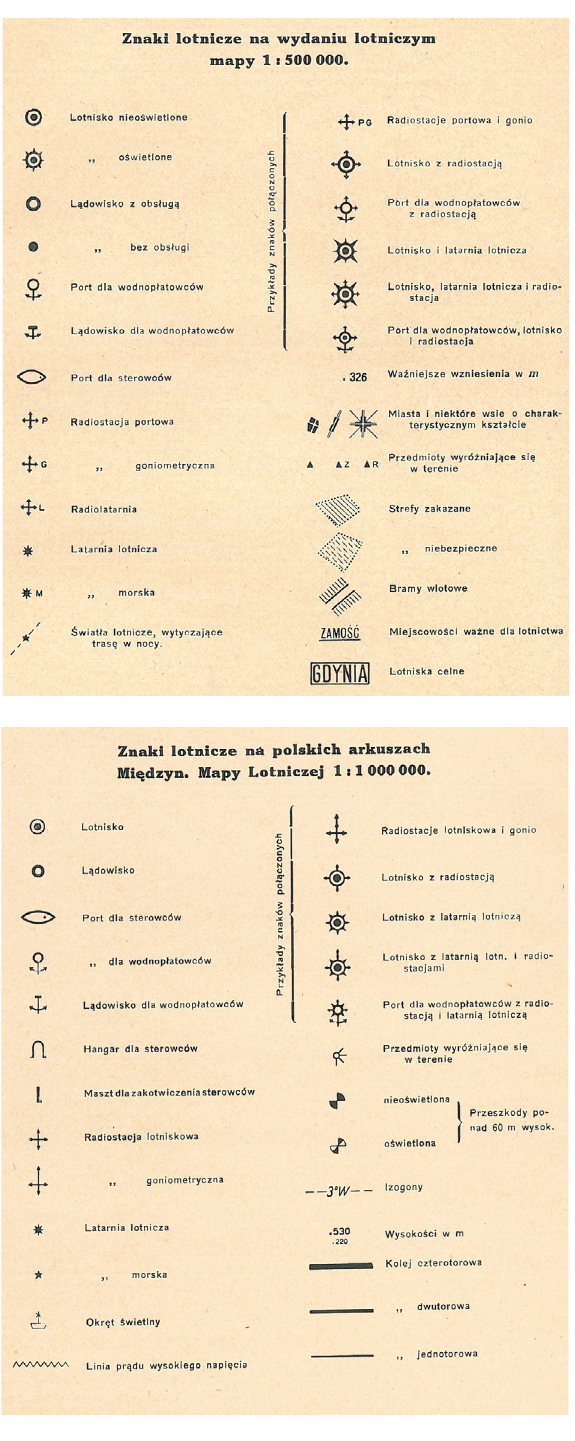
Fig. 2. Examples of special